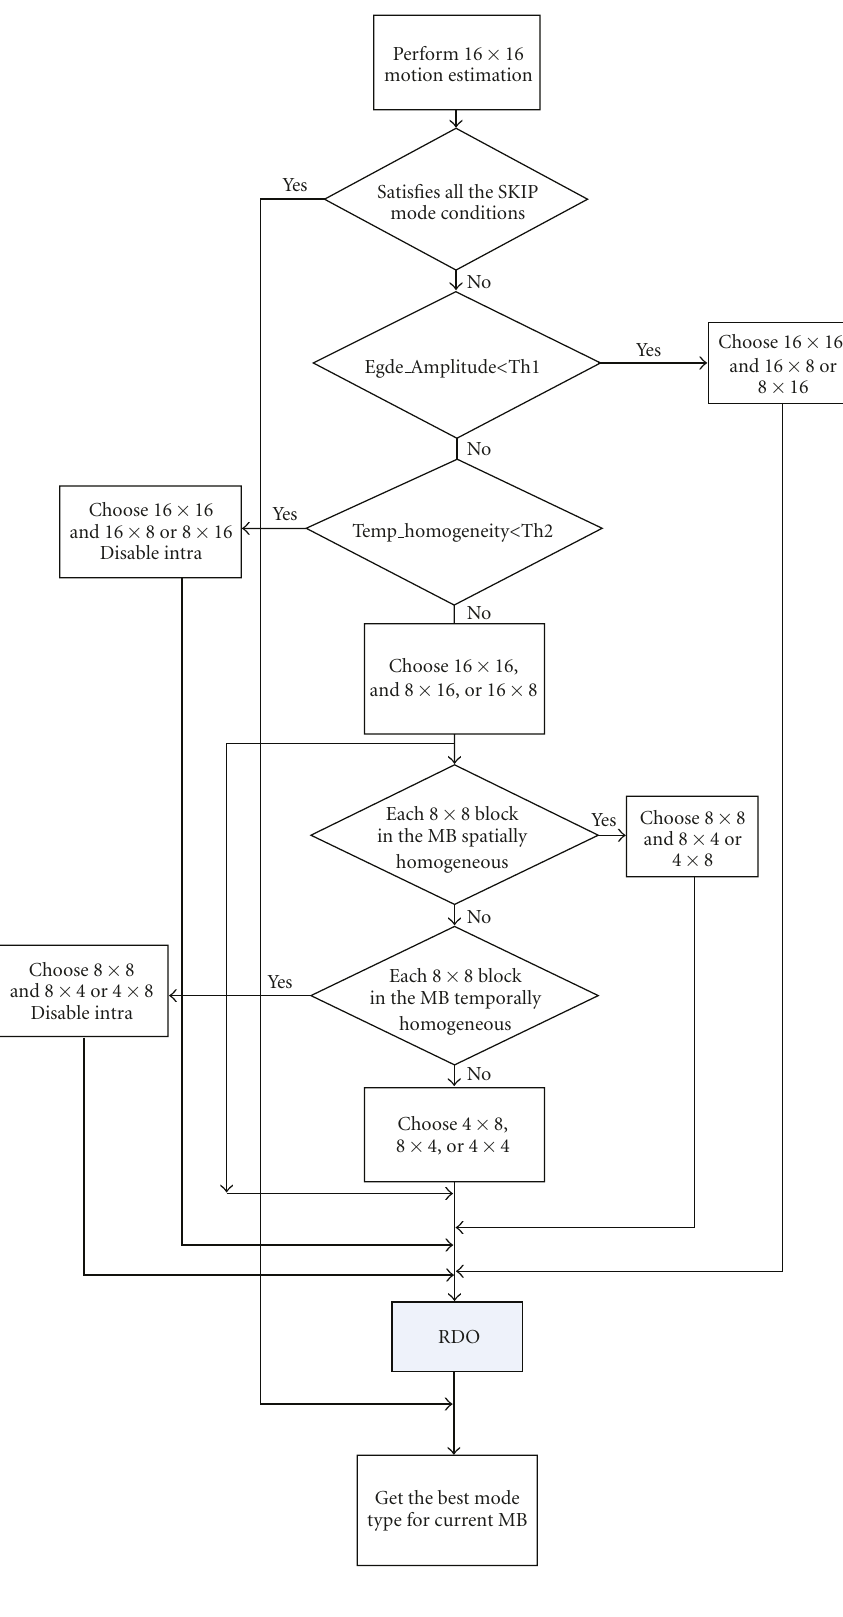
Figure 12: Proposed CRA